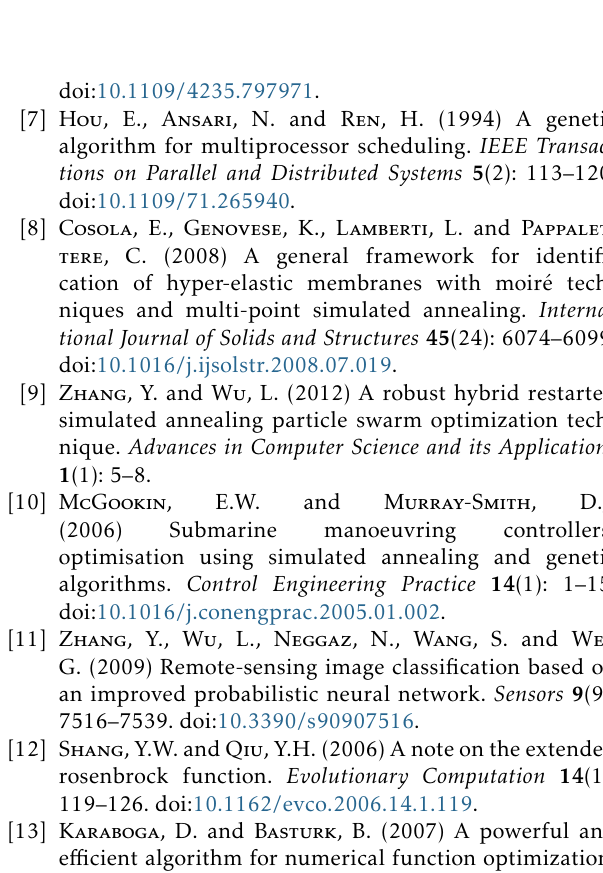
e ffi cient algorithm for numerical function